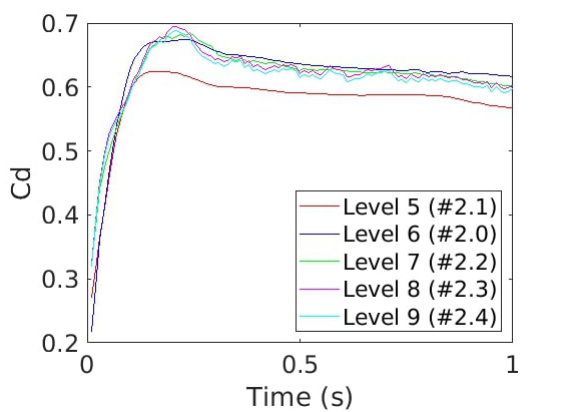
Figure 21. C d time evolution according to the level of refinement for cases #2.0 (blue), #2.1 (red), #2.2 (green), #2.3 (pink) and #2.4